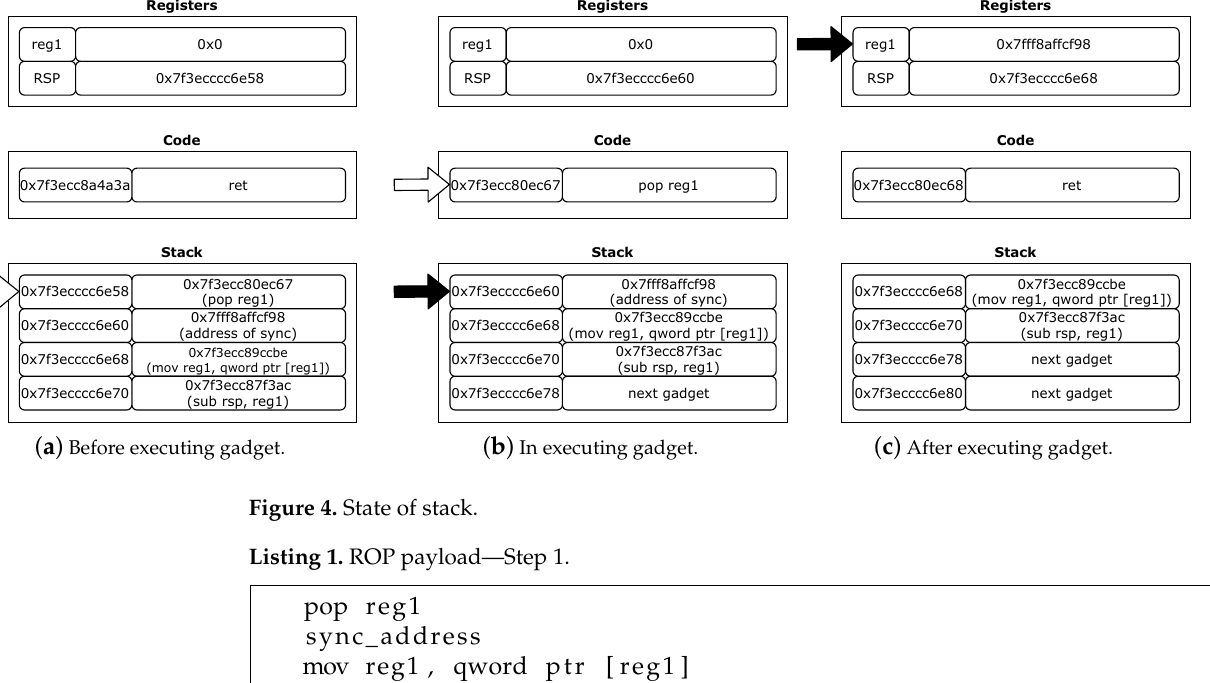
Figure 4. State of